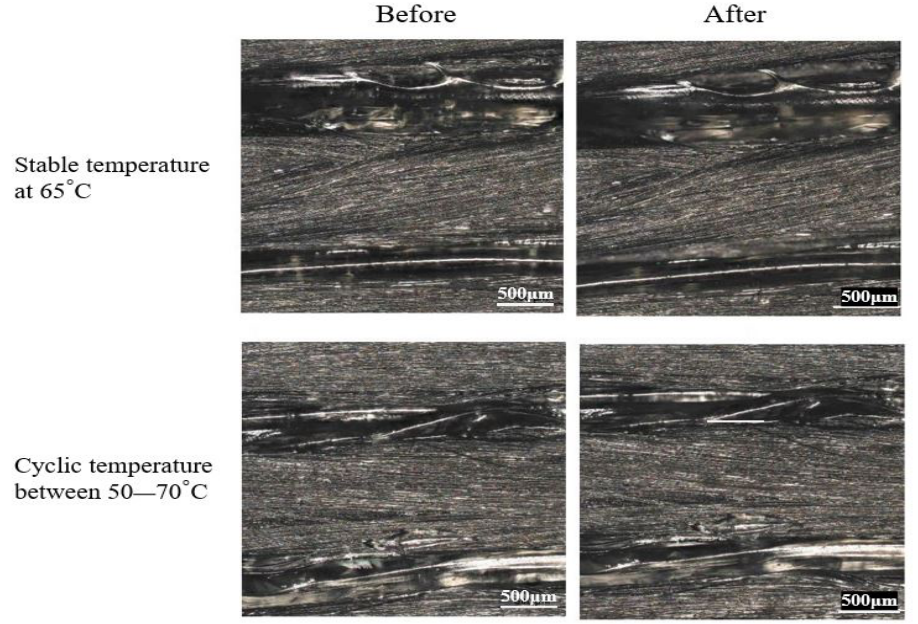
Figure 9. Optical micrographs of specimen before and after stable temperature at 65 ◦ C and cyclic temperature between 50 and 70 ◦